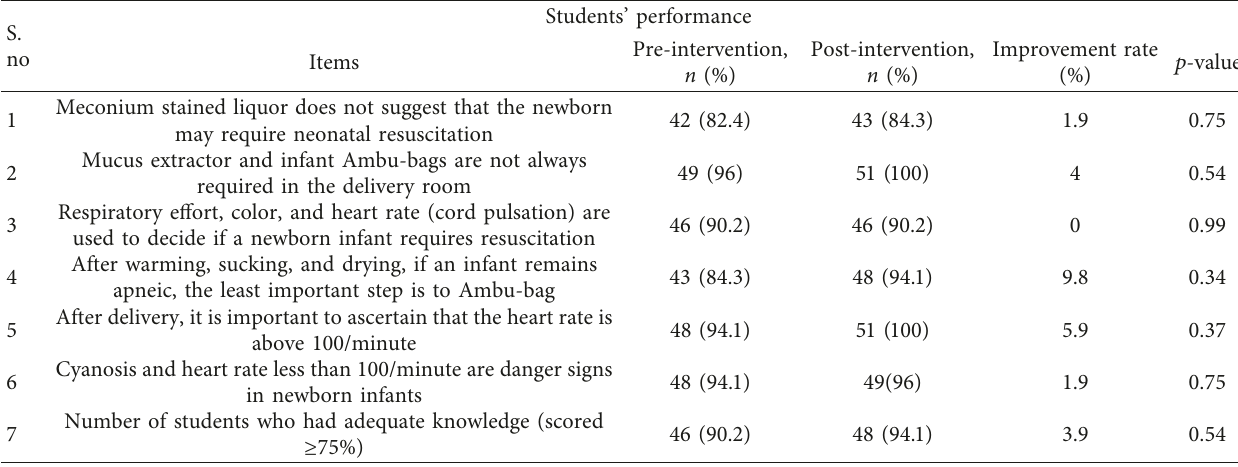
Table 4: Comparison of pre-intervention and post-intervention knowledge on evaluation in neonatal resuscitation of undergraduate final- year anesthesia students ( N � 51).